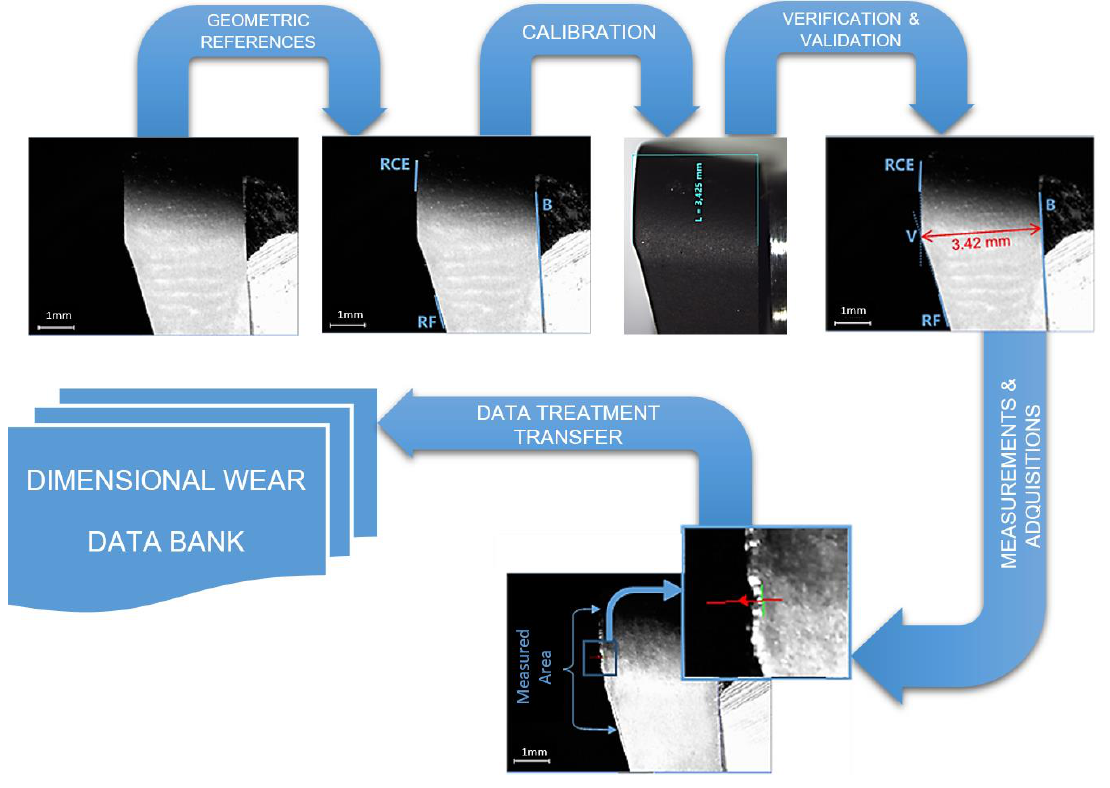
Figure 10. Wear metrological algorithm.